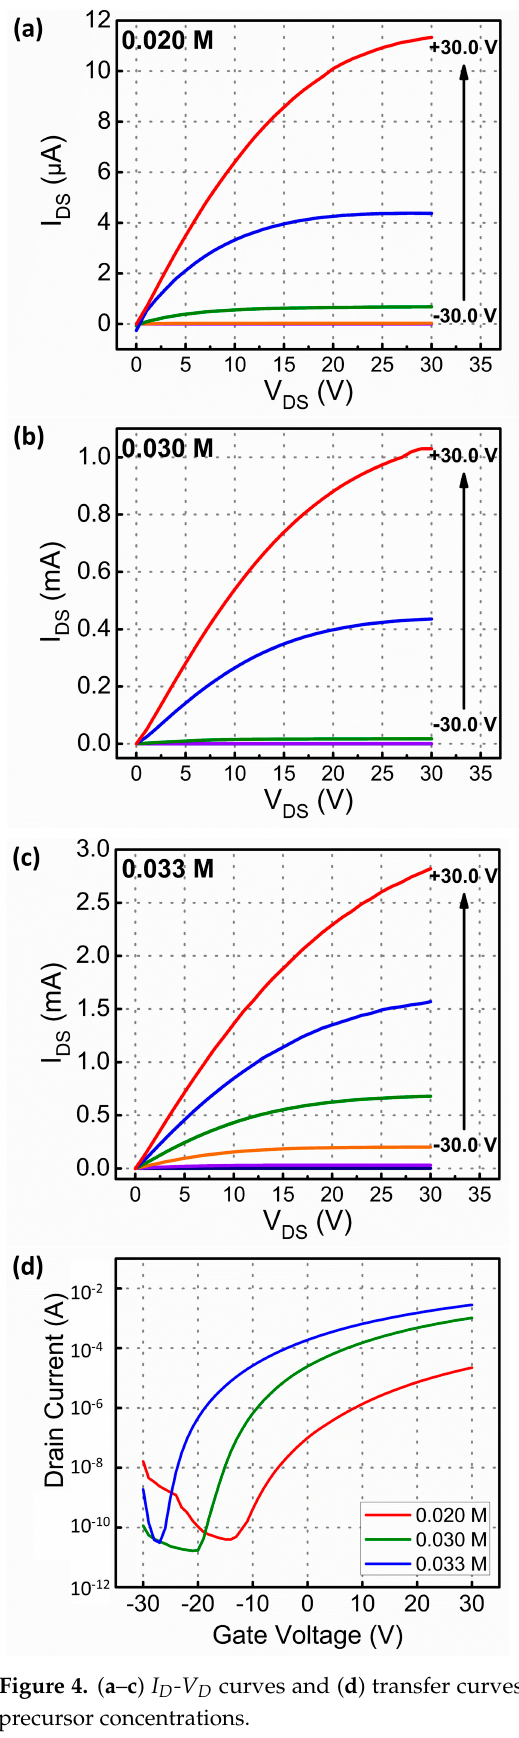
Figure 4. ( a – c ) I D -V D curves and ( d ) transfer curves of SnO 2 thin-film transistors as a function of precursor concentrations.